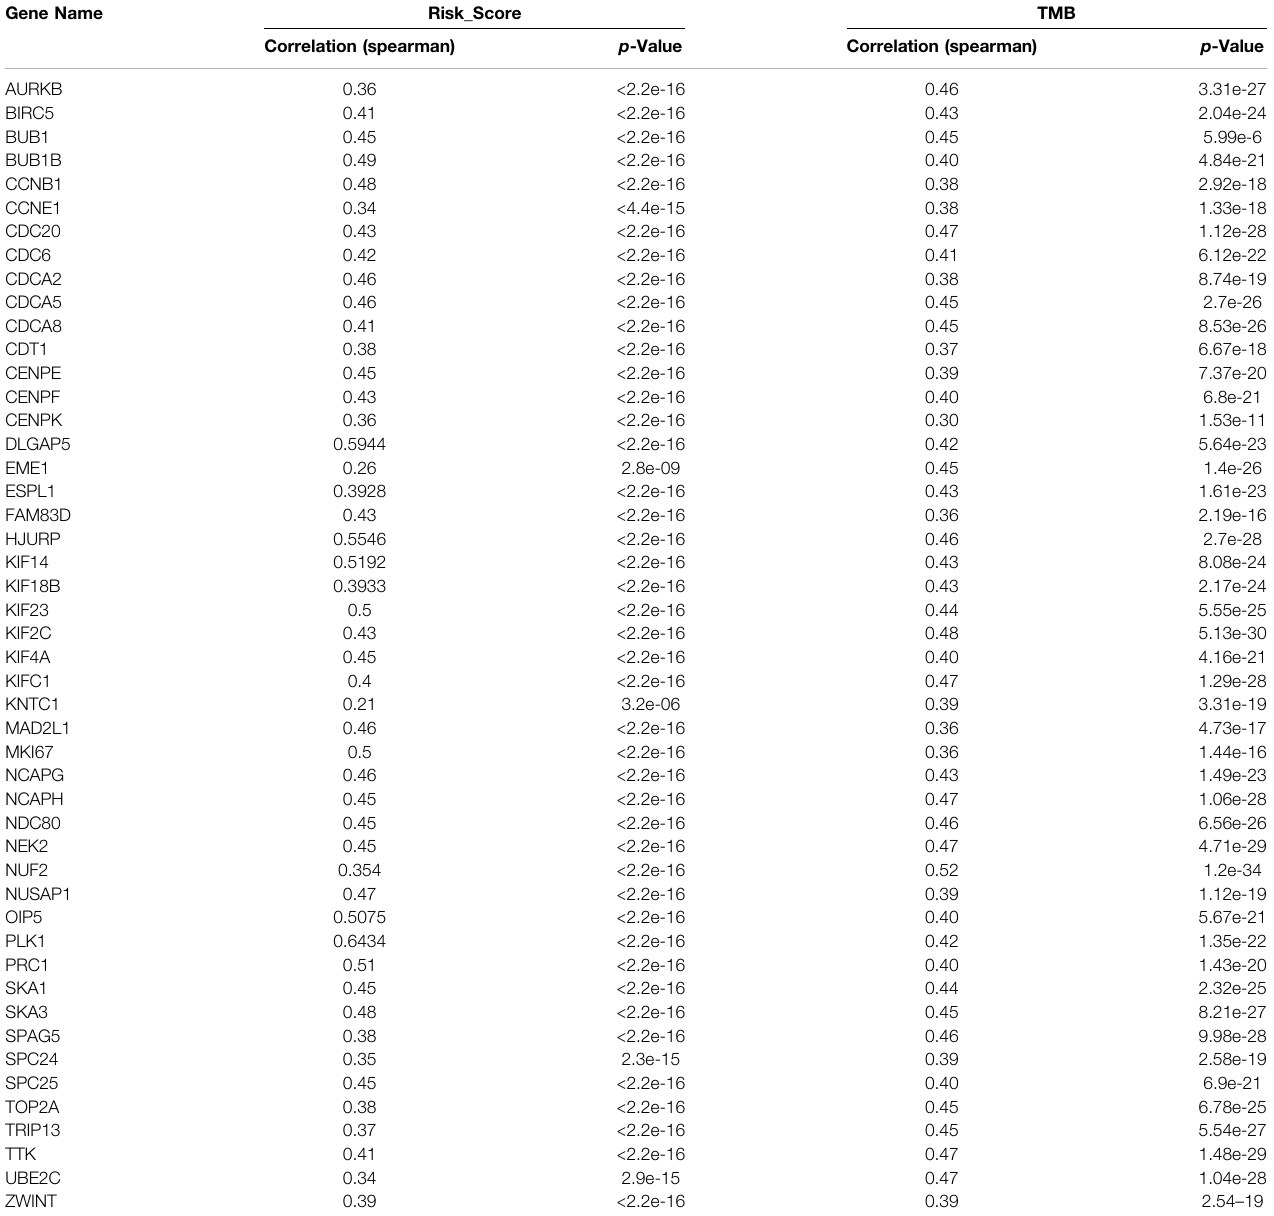
TABLE 1 | Correlation of CSRs with Risk_Score and